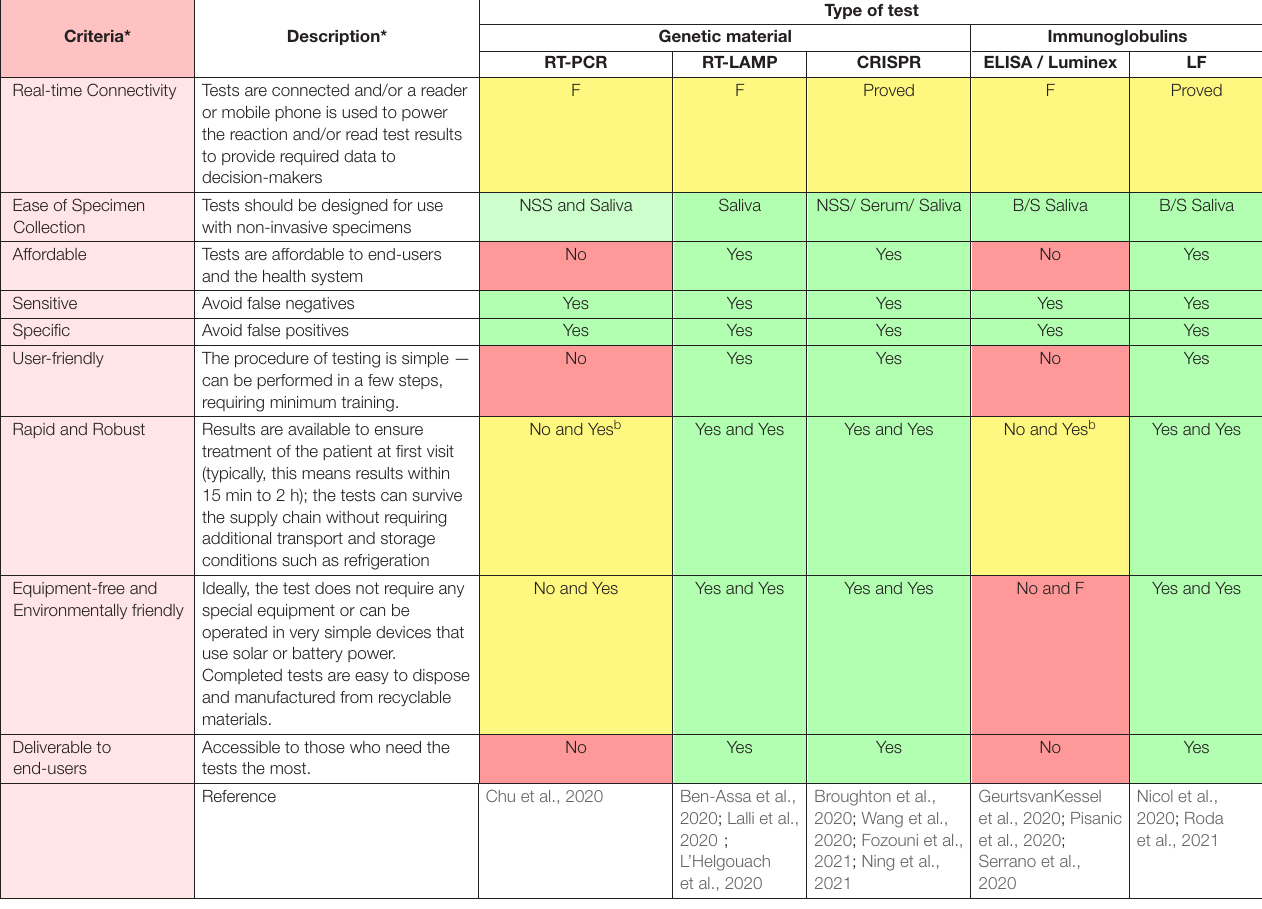
TABLE 1 | The evaluation of the main COVID-19 diagnostic tests/devices based on REASSURED